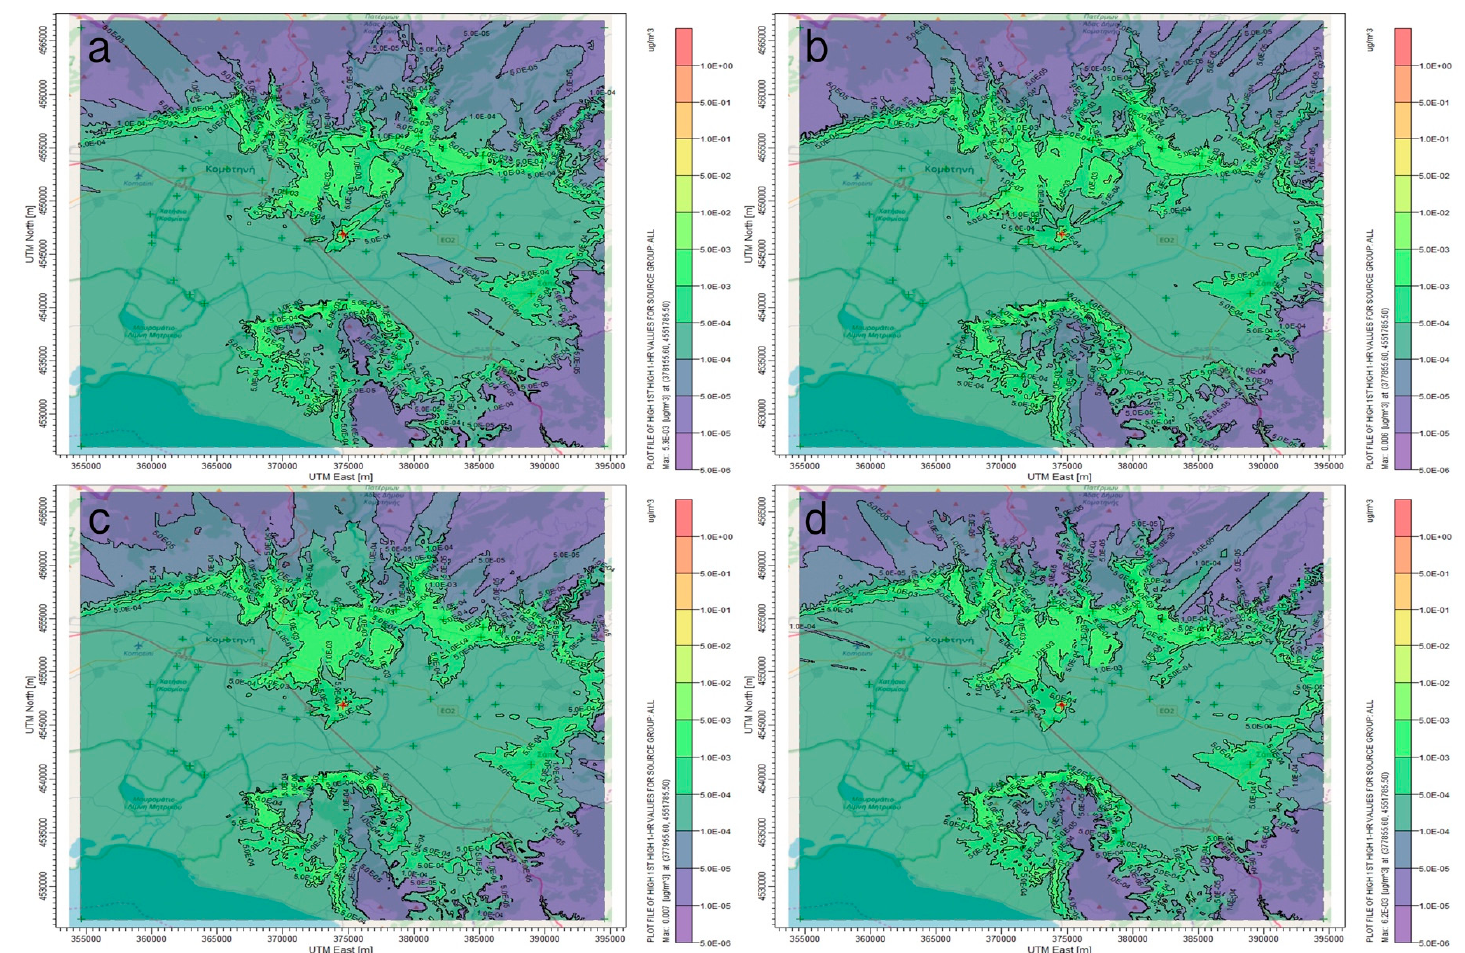
Figure 5. The highest hourly values of TSP of Pb ( µ g m − 3 ) ( a ) the typical operating conditions for 2015, ( b ) the typical operating conditions for 2016, ( c ) the typical operating conditions for 2017, and ( d ) the typical operating conditions for 2018.